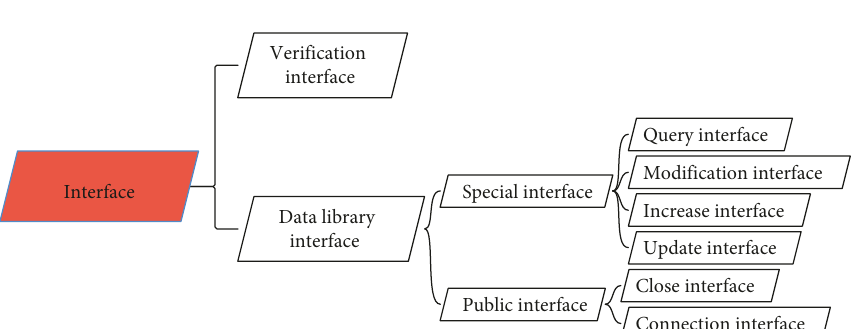
Figure 5: Data layer flow chart.